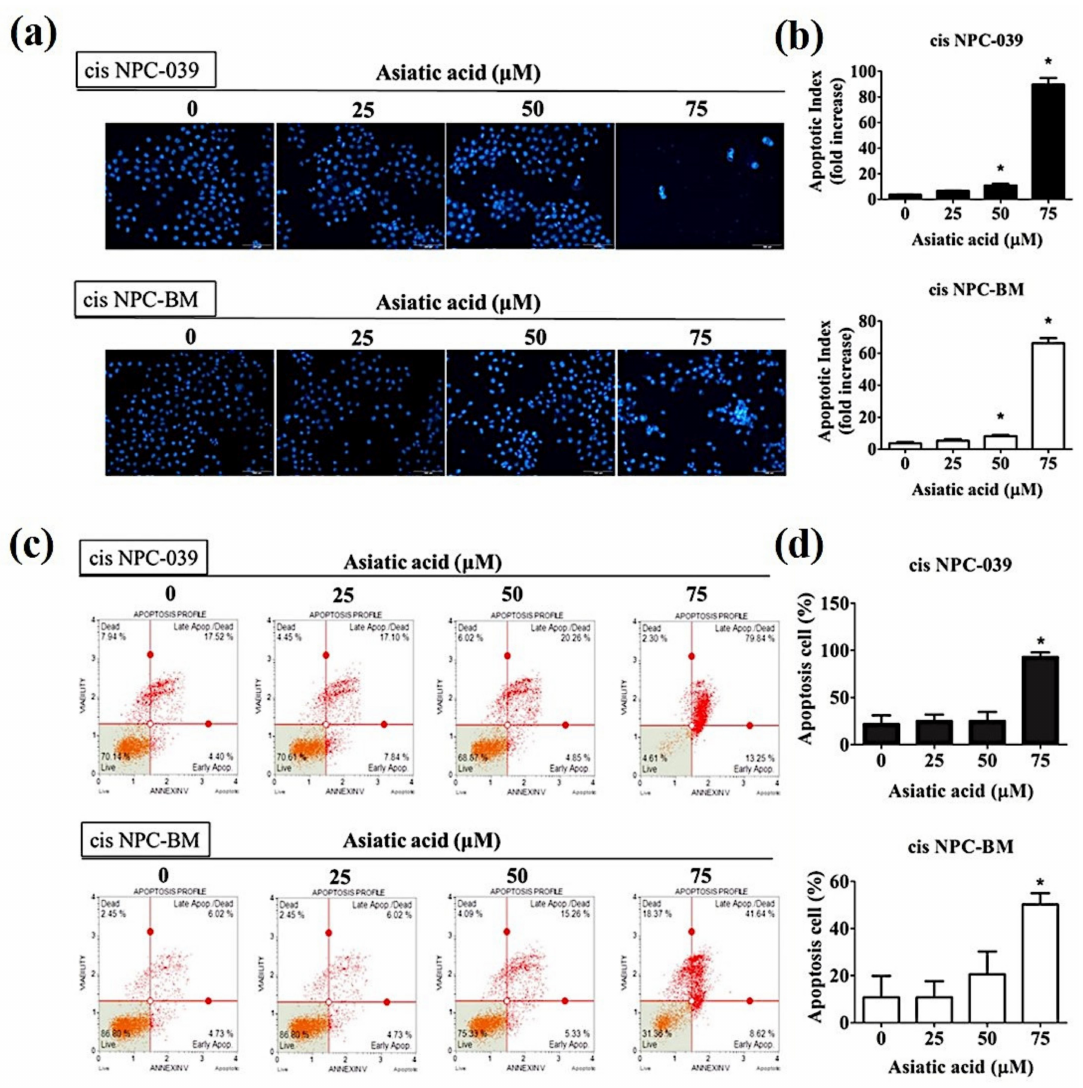
Figure 3. E ff ect of Asiatic acid on apoptosis induction in cis NPC-039 and cis NPC-BM cell lines. ( a ) Nuclear counterstain level was detected by DAPI staining. Characteristic ‘blebbing’ morphology of cell nucleus was observed by fluorescence microscopy. ( b ) The DNA condensation fold compared with control. ( c ) and ( d ) Cell apoptosis was analyzed by flow cytometric with Annexin-V / PI Staining. * p < 0.05 as compared with control